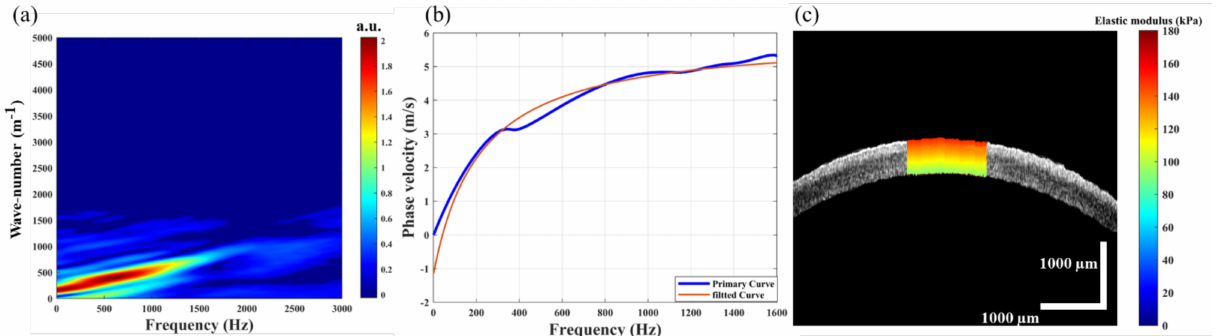
Figure 4. The phase velocity calculation of the Lamb wave in normal cornea, ( a ) is the wave number- frequency map of the Lamb wave, ( b ) is the phase velocity curve depends on the frequency, and ( c ) is the depth-resolved elastography result of the normal